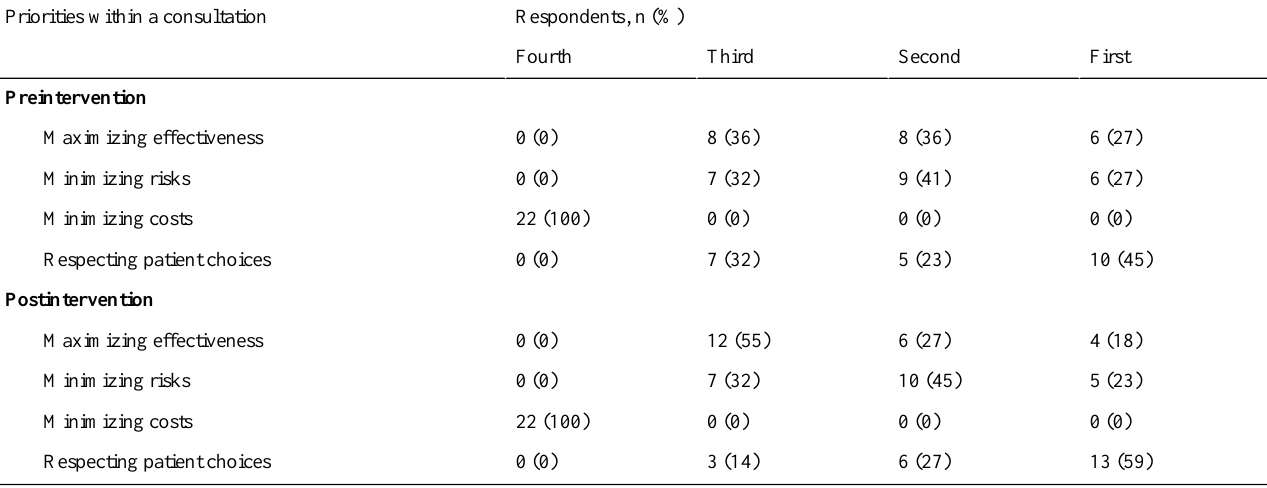
Table 4. Participants’priorities during a consultation, preintervention and